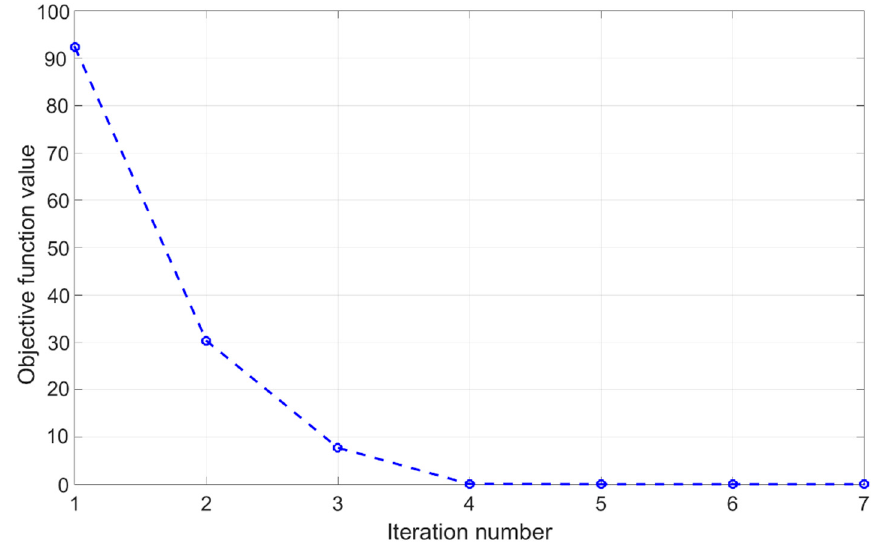
Figure 12. Convergence plots for the objective function.